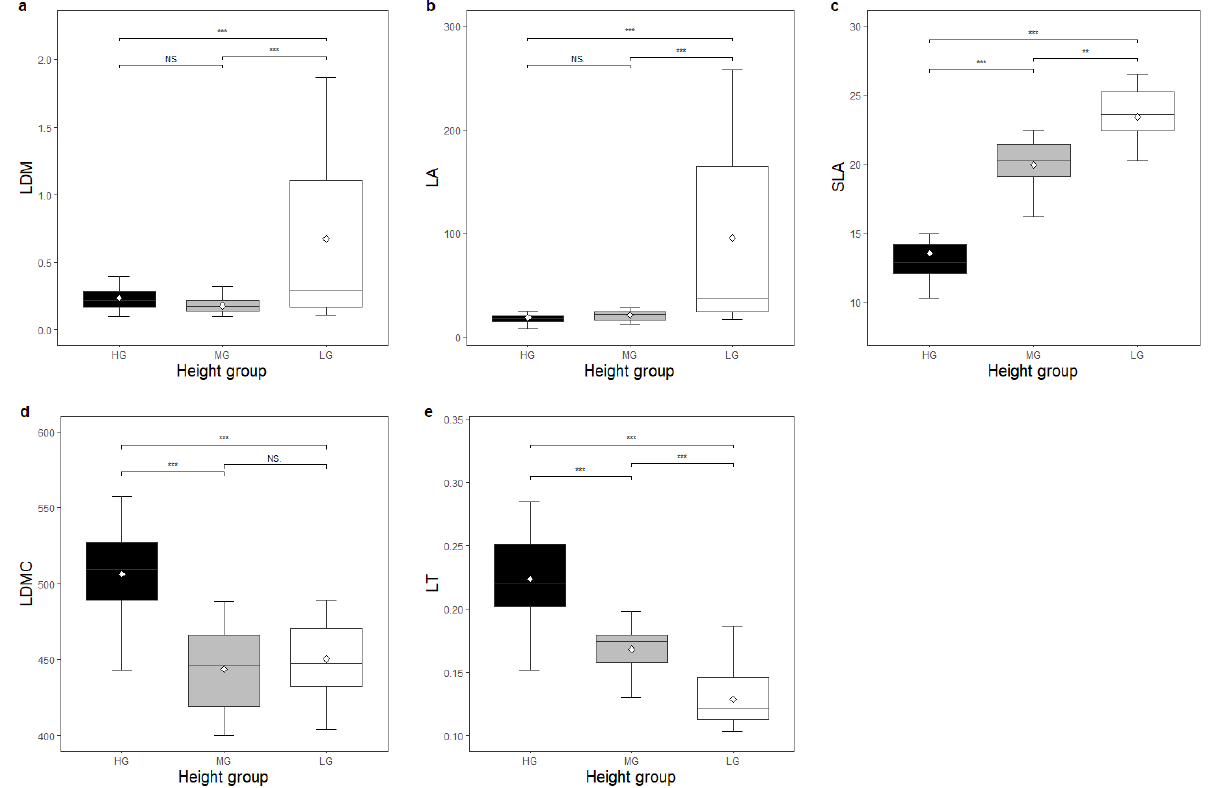
Figure 3. Leaf functional trait differences among height groups. Differences in each trait were checked using the Tukey test at a 95% family − wise confidence level. HG refers to the higher height group, comprising Machilus breviflora , Schima superba , and Castanopsis chinensis; MG refers to the middle height group, comprising Cryptocarya concinna and Cr . chinensis; LG refers to the lower height group, comprising Ca. fissa and M . chinensis . Black box represents HG, grey box represents MG and white box represents LG in each subfigure. LDM: leaf dry mass; LA: leaf area; SLA: specific leaf area; LDMC: leaf dry matter content; LT: leaf thickness. *** p < 0.001; ** p < 0.01; NS for not significant difference. Table 3. Correlation between species differences in functional traits and species differences of abundance in the five different height ranges. Spearman’s rank correlation test was used to assess the relationship.